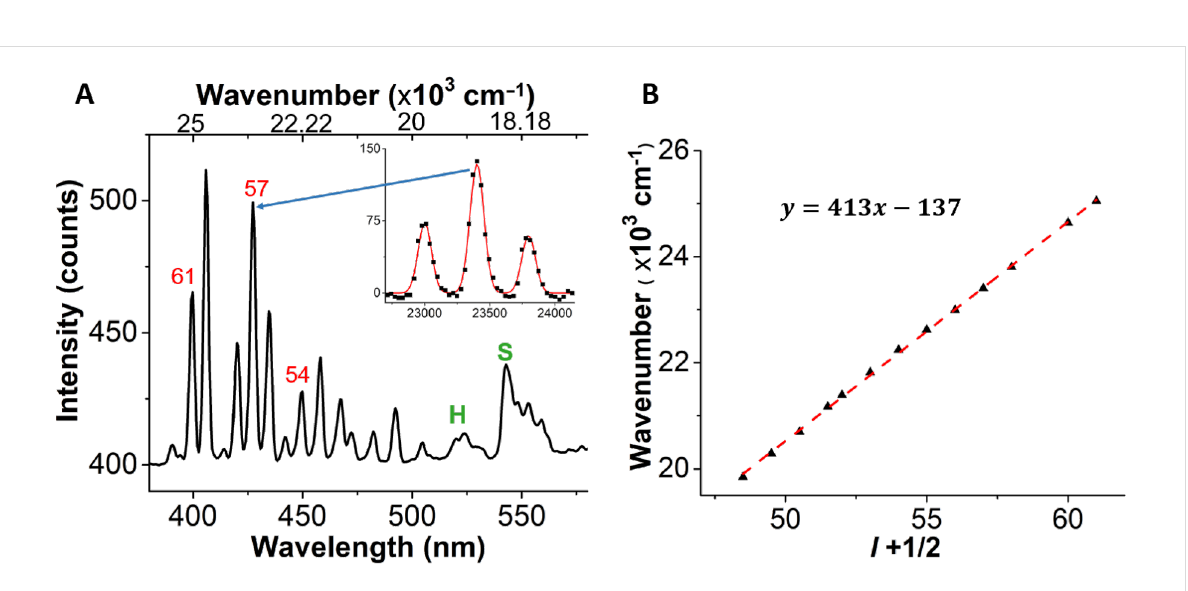
Figure 6: (A) A plot of intensity vs wavelength/wavenumber exhibiting whispering gallery modes at the tip of a Taylor cone indicated by a red circle in Figure 5A. The inset represents a peak profile, fitted with Gaussian to calculate the Q -factor. The values in red represent l + 1/2 values calculated using the respective peaks. (B) A plot of wavenumber vs l + 1/2 with slope 413 ± 3 and intercept of − 137 ± 158. The cavity radius is 2.87 ± 0.02